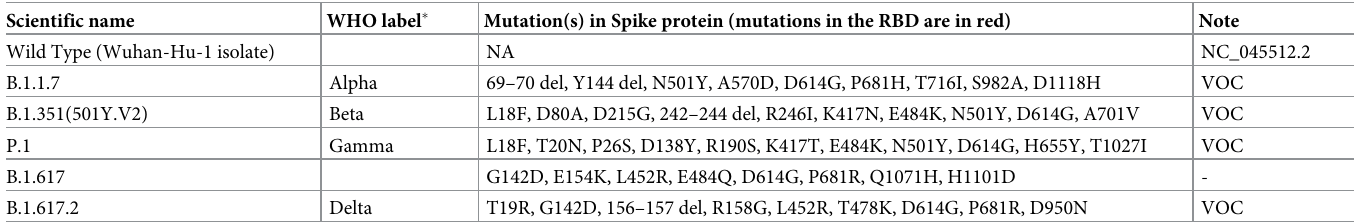
Table 2. SARS-CoV-2 variants of